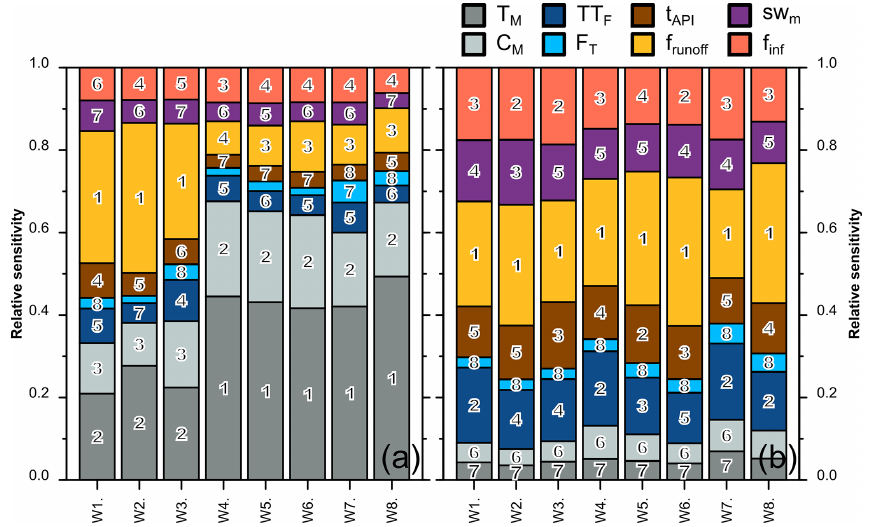
Figure 4. Relative sensitivity of the eight model parameters to the simulated river flow rates (a) and to the simulated potential groundwater recharge (b) for the eight groups of gauging stations. The relative parameter ranking is reported in the bars from the most sensitive, 1, to the least sensitive,